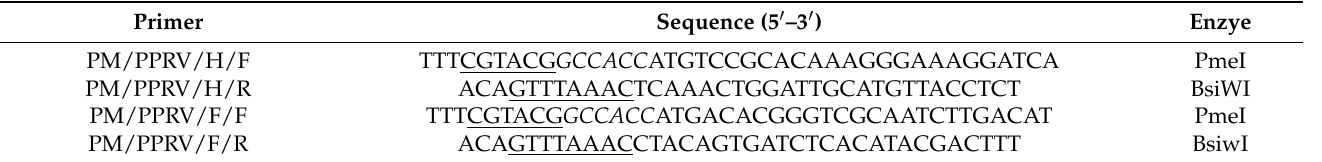
Table 1. Primers used in this